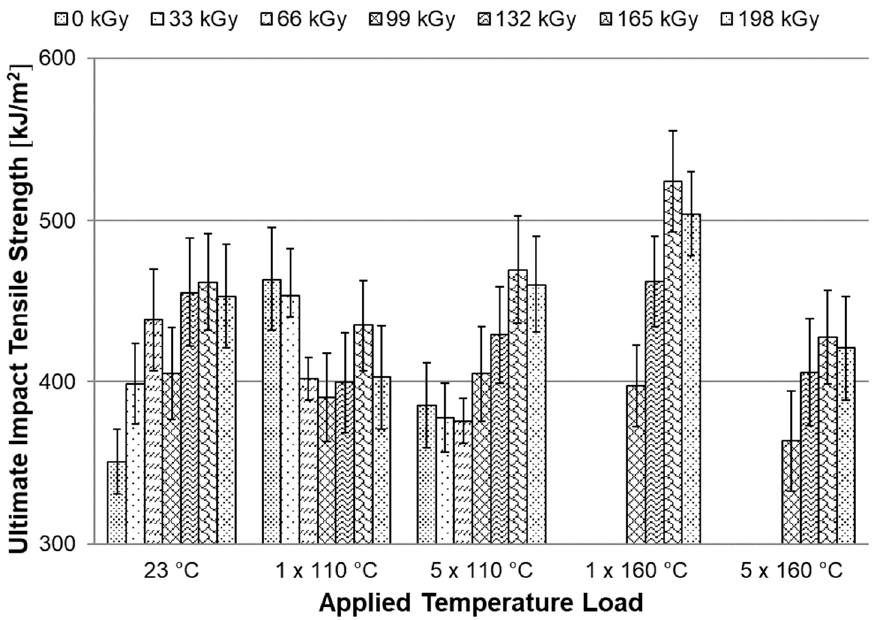
Figure 13. Dependence of the ultimate impact tensile strength on applied temperature load.